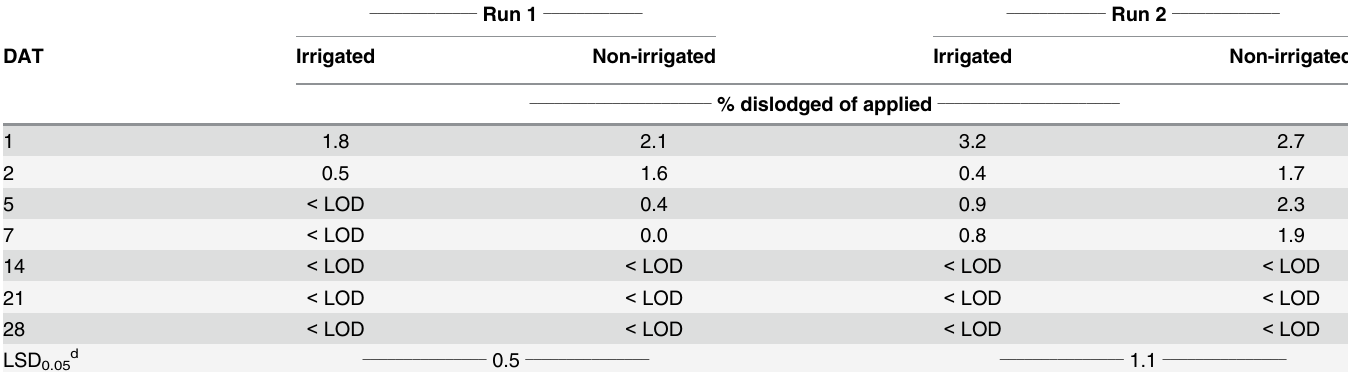
Table 3. The effect of irrigation on dislodgeable 2,4-D residues relative to the applied at trial initiation. a – c